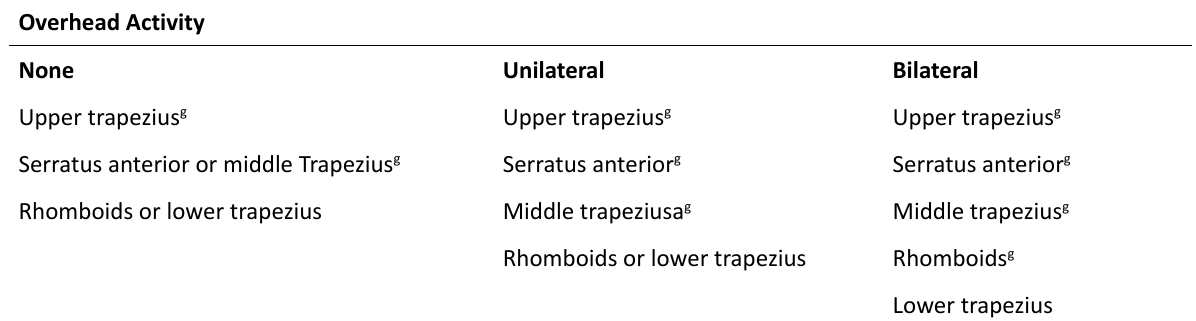
Note: g Indicates the strength of this muscle was significantly greater than those